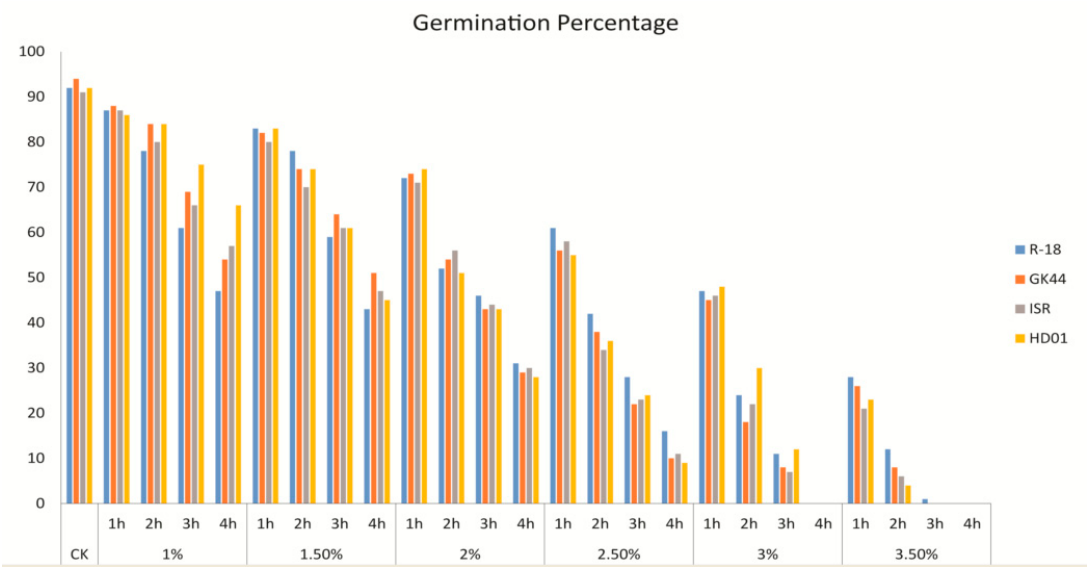
Figure 1. Determination of LD50 of ethylmethanesulfonate (EMS) treatment on different genotypes of cotton.